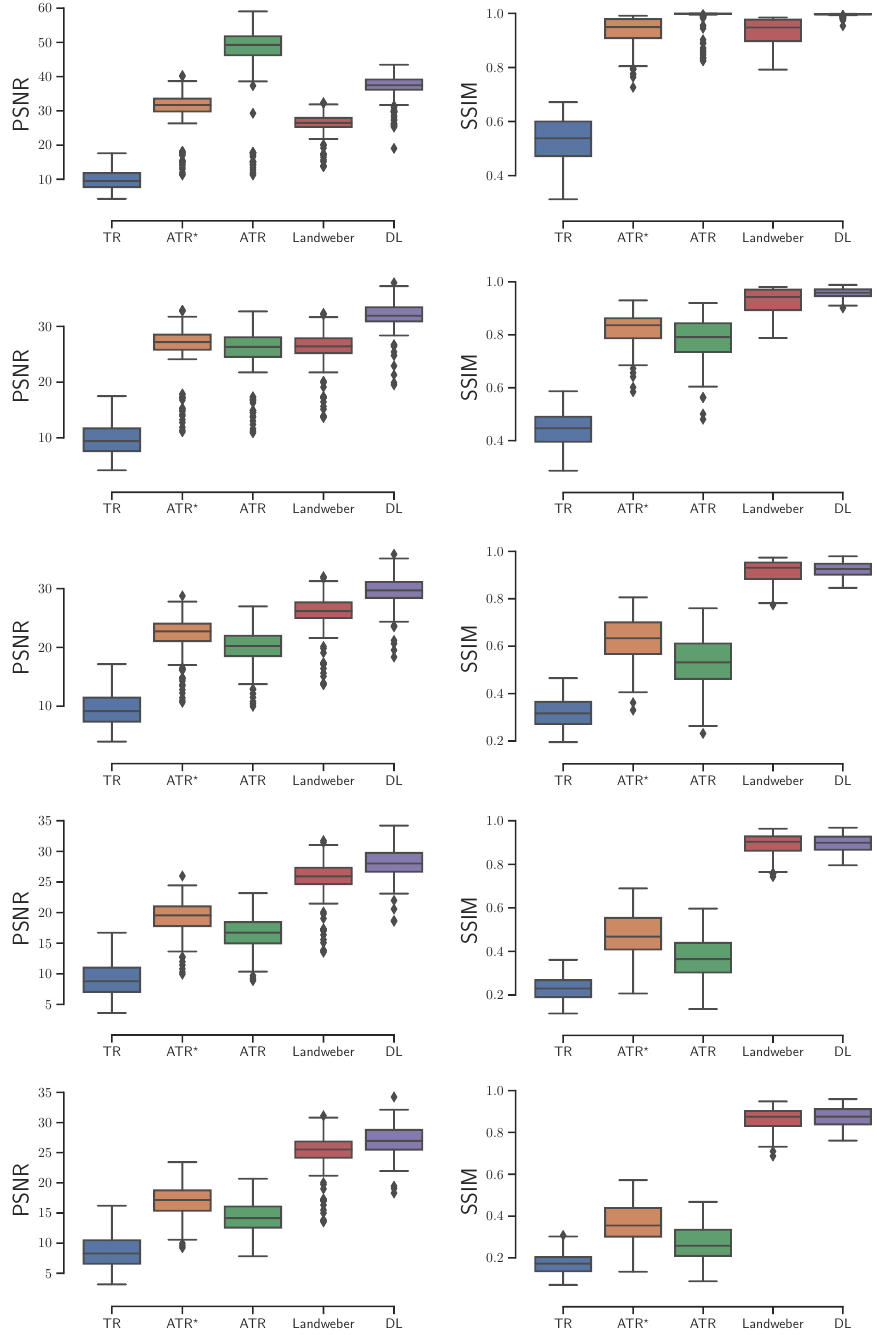
Figure 3. The box plots of the image quality evaluated by PSNR and SSIM on the testing set in a homogeneous medium. From top row to bottom row: noise increases from 0 to 0.4. Diamonds ( (cid:5) ) indicate